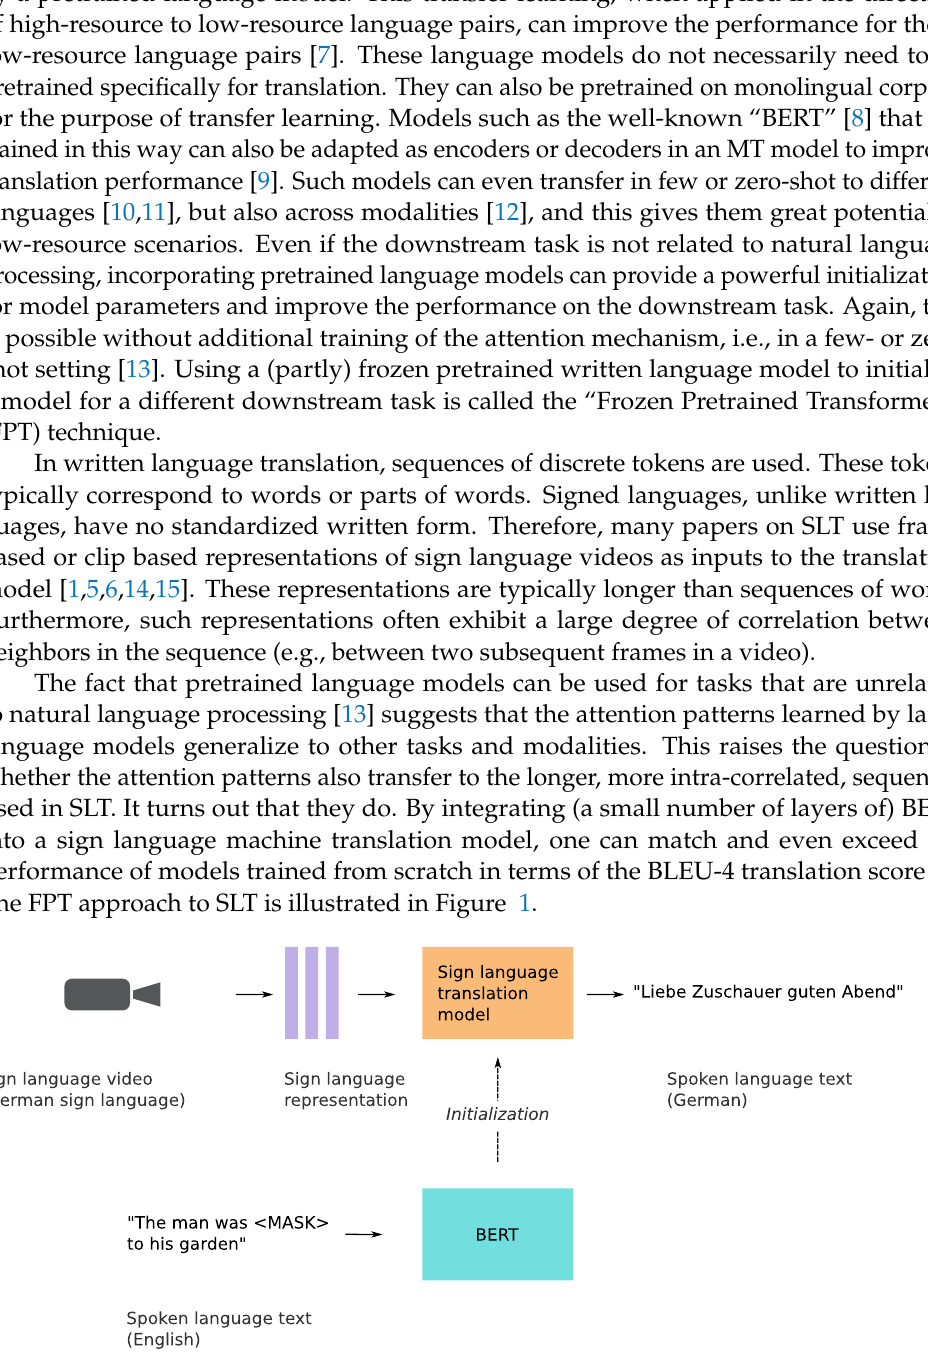
Figure 1. In our proposed approach to SLT, pretrained written language models are integrated into the SLT pipeline as initialization for (parts of) the translation model, and then partly frozen and partly fine-tuned on the translation task